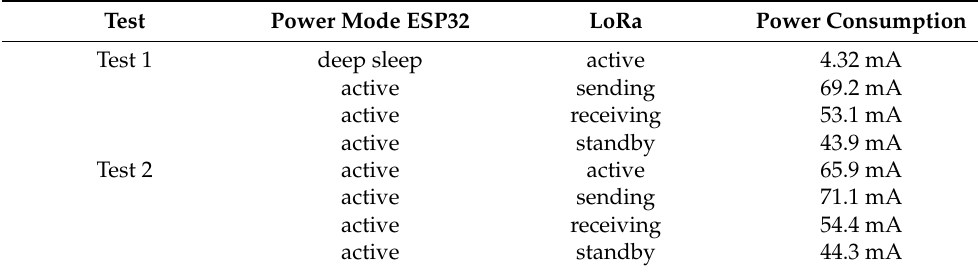
Table 1. Power consumption